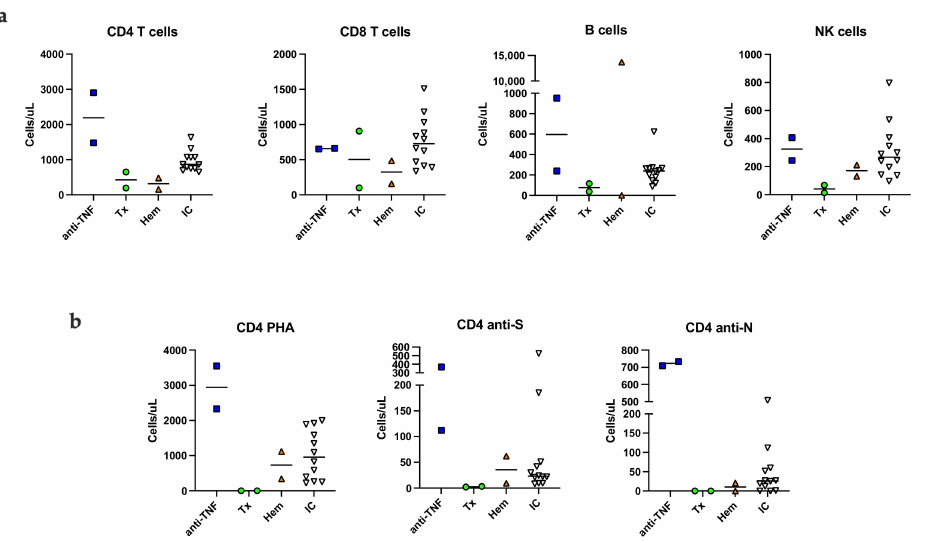
Figure 1. SARS-CoV-2 specific T cell responses in activated whole blood. Absolute number (cells/ µ L) of lymphocyte subsets in unstimulated peripheral blood ( a ). The number of PHA, S- and N-specific stimulated, blast transformed CD4 T cells ( b ). Anti-TNF; patients on TNF inhibitor, Tx; kidney trans- plant recipient, Hem; patients with myeloma or chronic lymphocytic leukemia, IC; immunocompetent patients, NK; natural killer cell, S; spike peptide, N; nucleocapsid